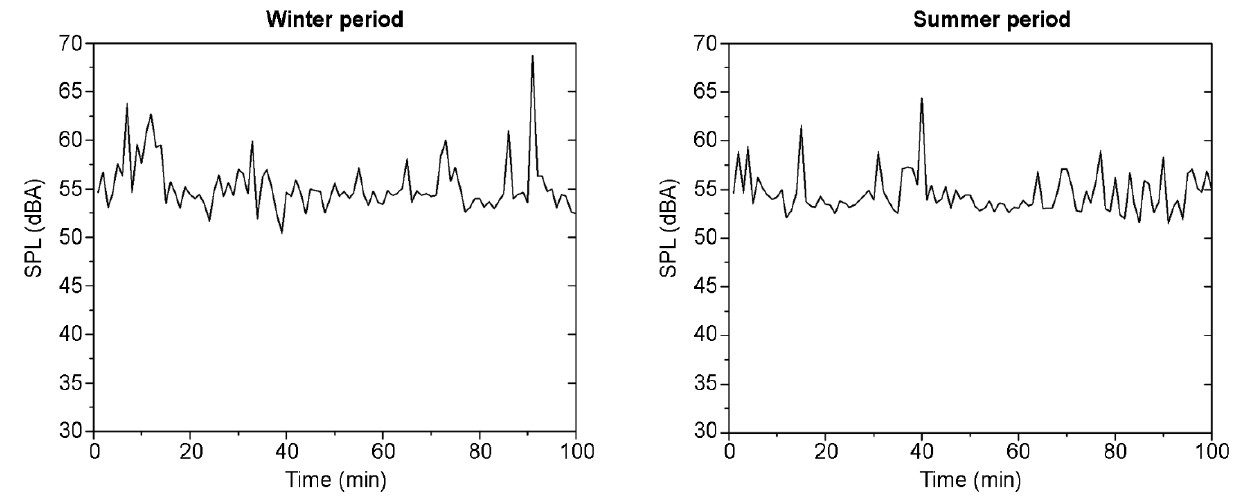
Figure 7. Background noise level (dBA) data obtained in both assessment periods.